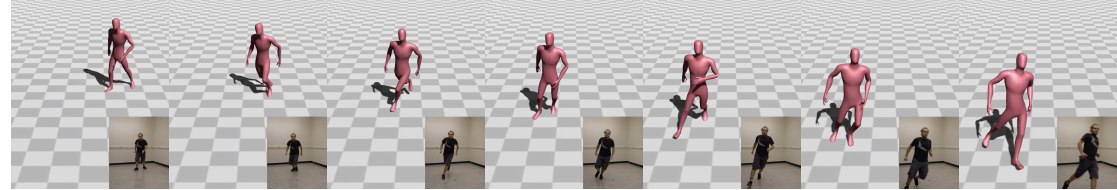
Figure 1. A reconstructed running motion when the user follows a curved path.